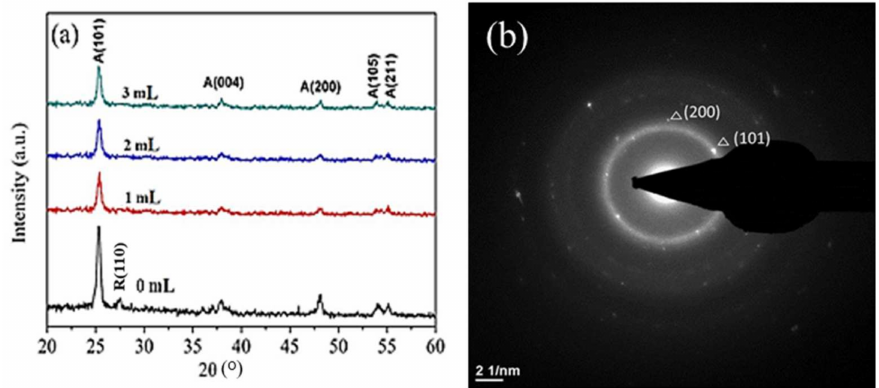
Figure 7. X-ray diffraction spectrum for ( a ) the mixed Acac (0, 1, 2, and 3 mL) with a TiO 2 mesoporous layer ( b ) TEM image of the TiO 2